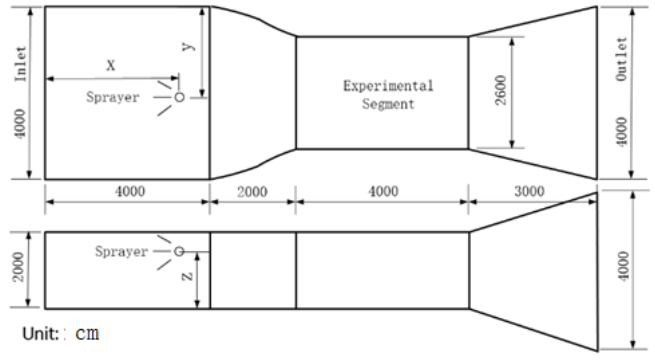
Figure 2. Structural diagram of the experimental wind tunnel.